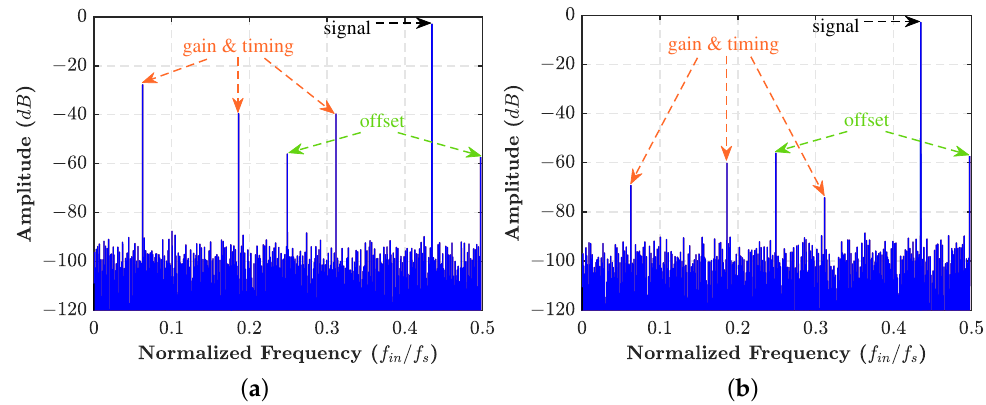
Figure 13. The frequency spectra of the TIADC output with offset and gain mismatches when f in / f s = 0.437: ( a ) before calibration (SNDR = 24.04 dB, SFDR = 24.57 dB); ( b ) after calibration (SNDR = 50.28 dB, SFDR = 53.04 dB).